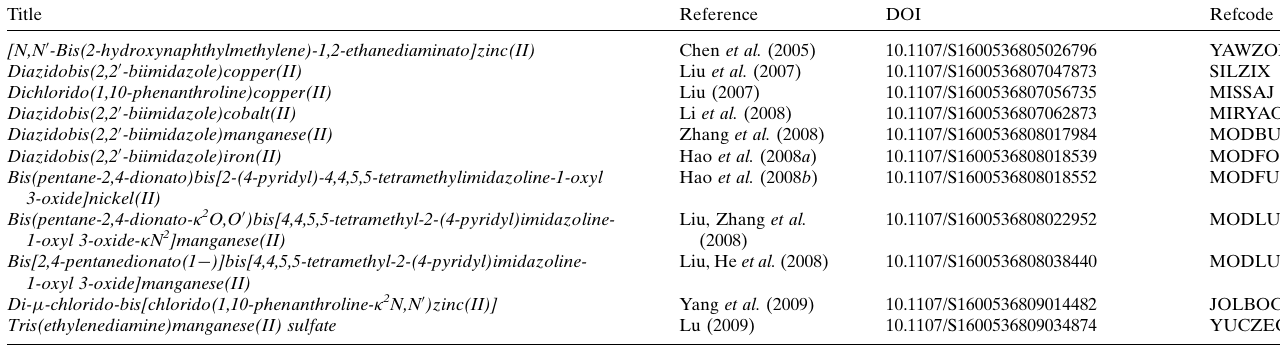
Details of articles to be retracted, in order of